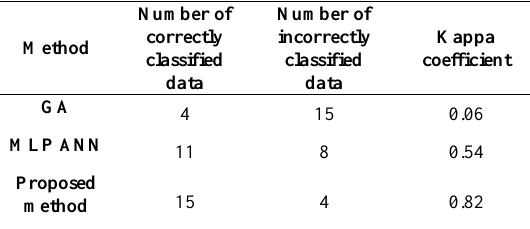
Table 3. Results of proposed method for testing dataset.